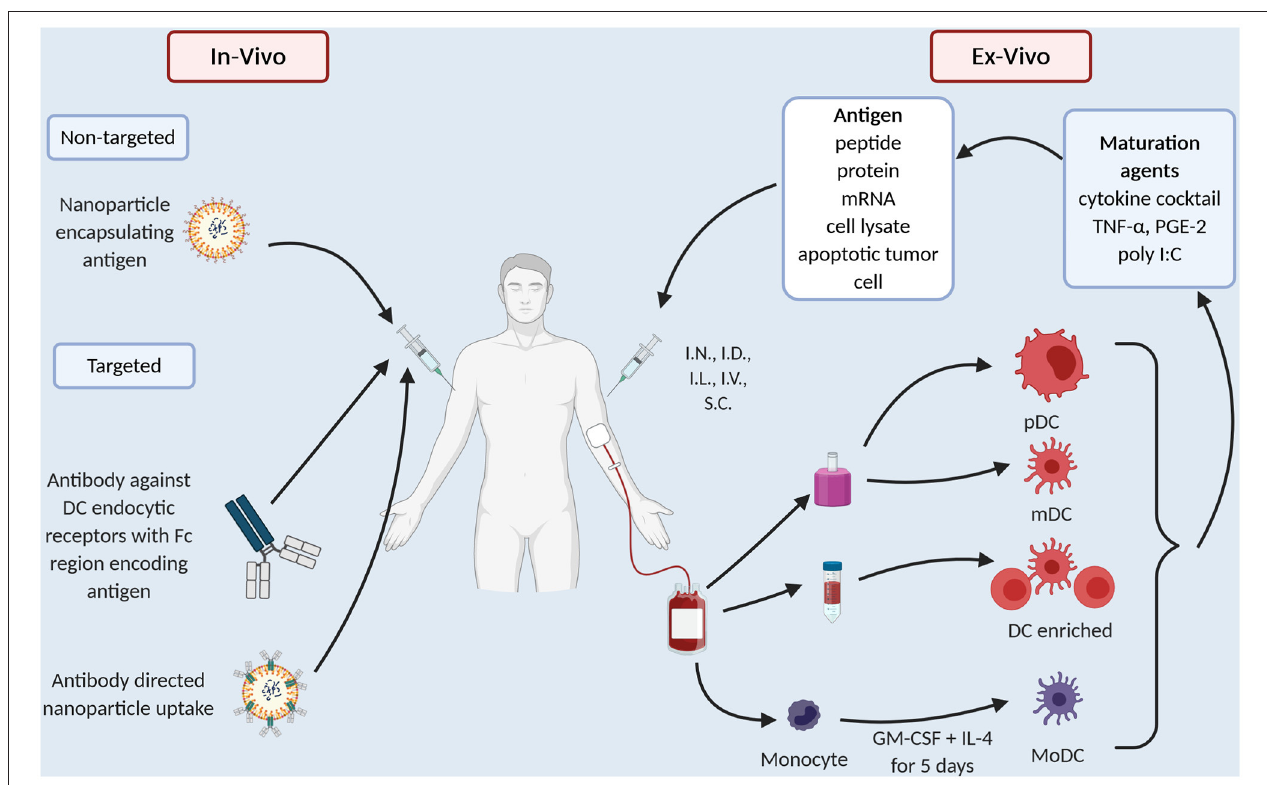
FIGURE 1 | Current dendritic cell vaccination